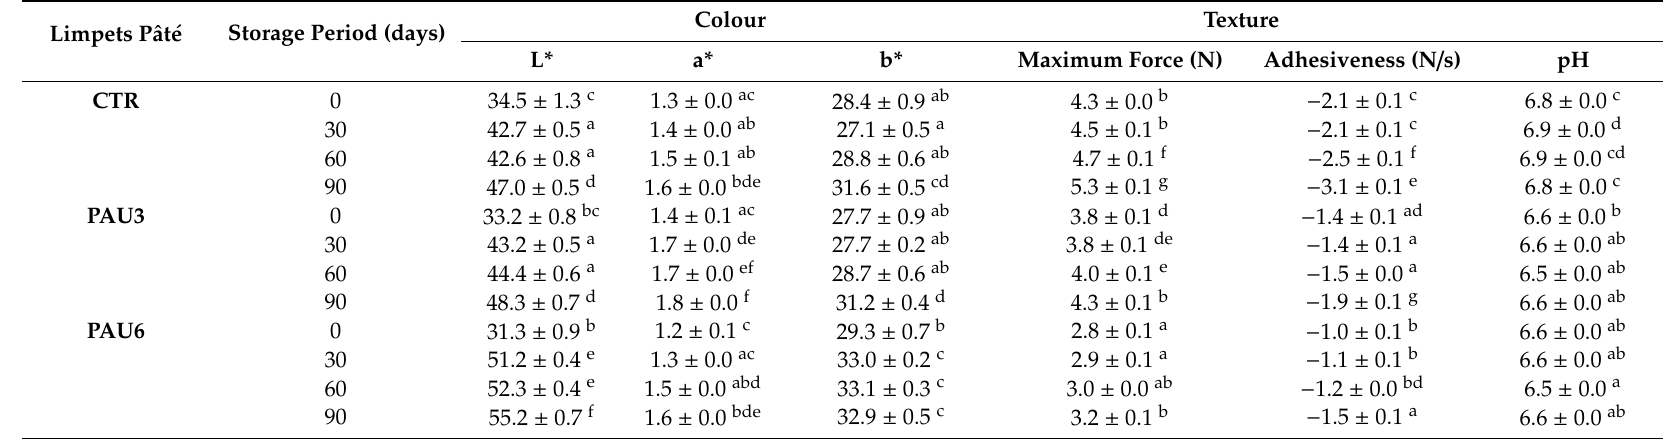
Di ff erent letters represent significant di ff erences ( p -value <